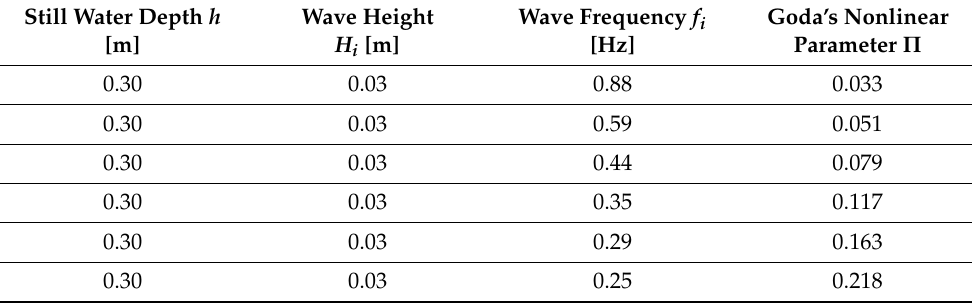
Table 3. Incident regular waves used in the forced oscillation experiments.